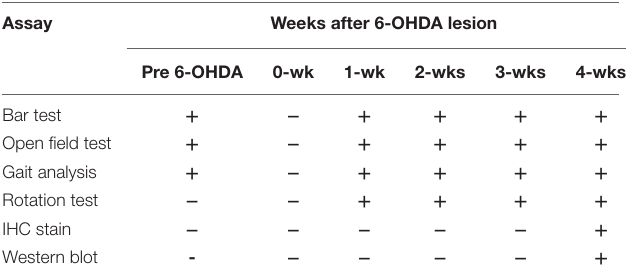
TABLE 1 | Timetable of behavioral and biochemical examinations on Parkinson’s disease (PD) rat model.